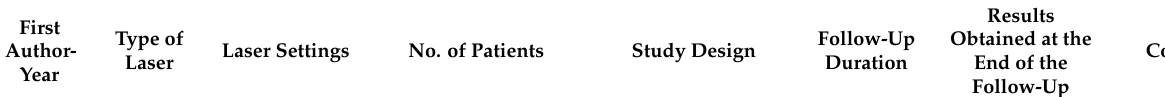
Table 1. Use of Er:YAG laser in peri-implantitis